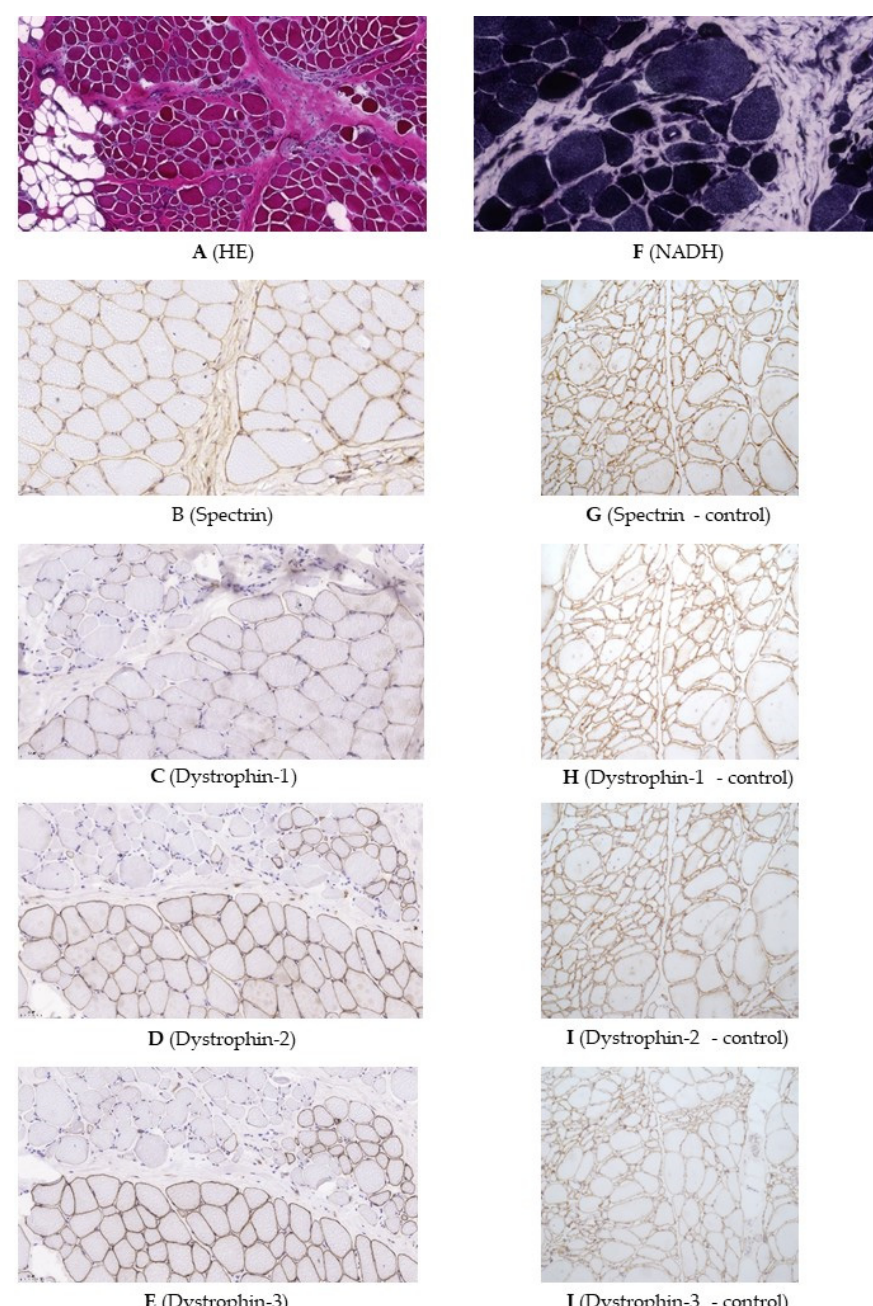
Figure 2. Muscle biopsy, magnifications used between 110×–320×. ( A ) Histological examination showed variation in fiber size, increased number of internal nuclei, necrotic fibers, pericellular fibrosis, and adipose tissue infiltrates (HE: hematoxylin-eosin). ( B ) The spectrin expression was reduced in several fibres. ( C – E ) Dystrophin expression showed segmentally severely reduced or completely lost sarcolemmal staining with the co-presence of fascicles showing normal, linear sarcolemmal dystrophin expression. ( F ) NADH-TR (nicotinamide adenine dinucleotide-tetrazolium reductase) staining showed irregular myofibrillar structure in several fibers. ( G ) Spectrin expression in the control. ( H – J ) Dystrophin expression in the